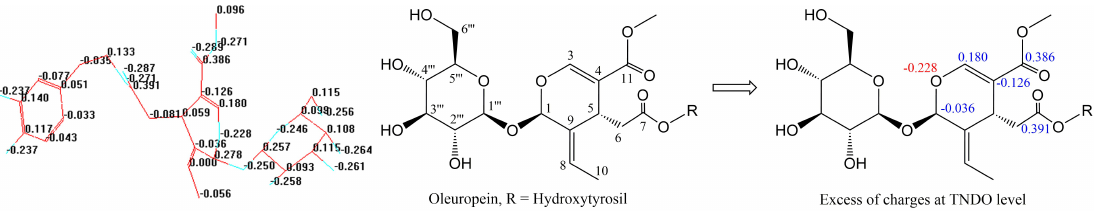
Figure 4. Frontier molecular orbital (FMO) interactions of oleuropein lowest unoccupied molecular orbital (LUMO) and OH − highest occupied molecular orbital (HOMO).